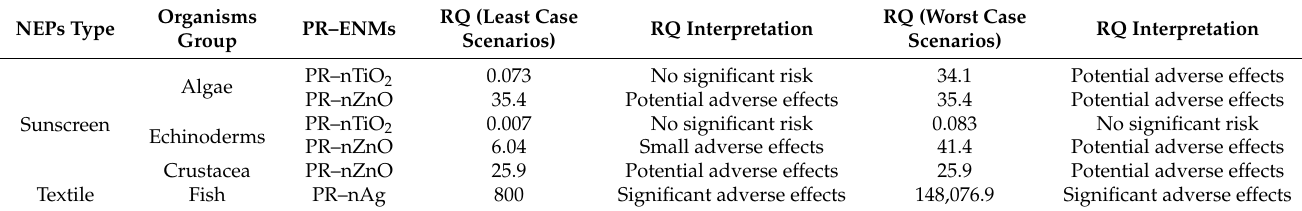
Table 4. The PR–ENMs risk characterisation estimates for different